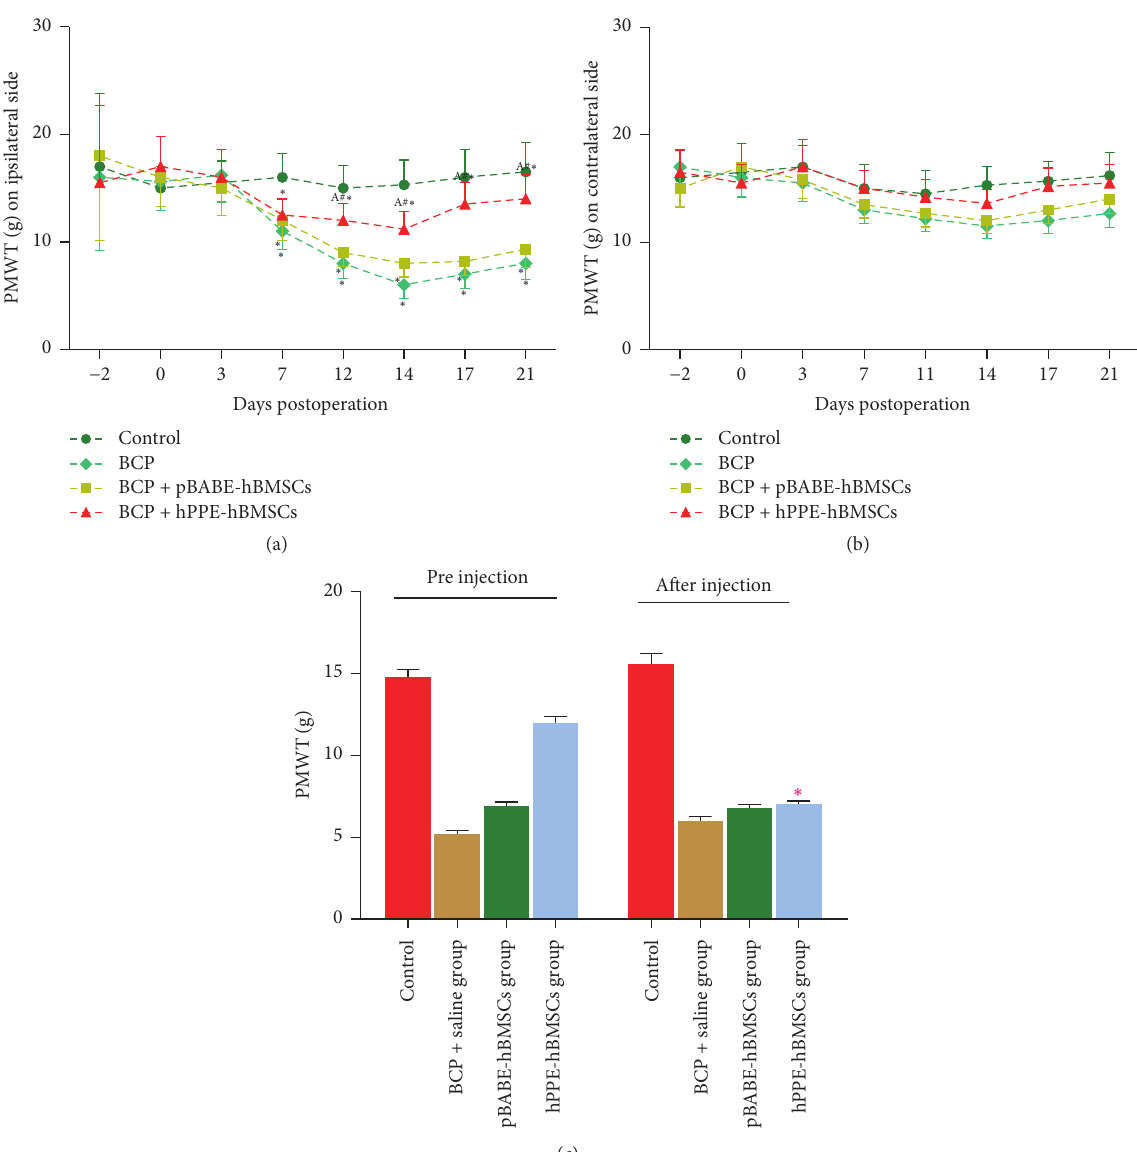
Figure 5: (a) Comparison of the paw mechanical withdrawal threshold (PMWT) indicating mechanical hyperalgesia changes on the ipsilateral side during the time course of Walker 256 cell incursion. Mechanical allodynia occurred starting on day 7, peaked on day 14, and then weakened until day 21. A significant decrease in PMWT was shown in the BCP, BCP + pBABE-hBMSCs, and BCP + hPPE-hBMSCs groups compared with the control group ( 𝑃 < 0.05 ), and treatment with hPPE-hBMSCs impaired the decrease in PMWT caused by cell administration. PMWT in the hPPE-hBMSC group was significantly higher than that in the BCP and pBABE-hBMSC groups ( 𝑃 < 0.05 ). ∗ 𝑃 < 0.05 versus the control group; # 𝑃 < 0.05 versus the BCP group; A 𝑃 < 0.05 versus the pBABE-hBMSC group. BCP, bone cancer pain; hPPE, human proenkephalin; pBABE, a retroviral vector; hBMSCs, human bone marrow stem cells; Control, the control group; BCP, the BCP + saline group; pBABE-hBMSCs, the pBABE-hBMSC group; hPPE-hBMSCs, the hPPE-hBMSCs group. 𝑛 = 6 . (b) Comparison of the paw mechanical withdrawal threshold (PMWT) indicating mechanical hyperalgesia changes on the ipsilateral side during the time course of Walker 256 cell incursion. There were no significant differences among the groups ( 𝑃 > 0.05 ). BCP, bone cancer pain; hPPE, human proenkephalin; pBABE, a retroviral vector; hBMSCs, human bone marrow stem cells; Control, the control group; BCP, the BCP + saline group; pBABE-hBMSCs, the pBABE-hBMSC group; hPPE-hBMSCs, the hPPE-hBMSC group, 𝑛 = 6 . (c) Naloxone was used to reverse the antiallodynia effect of met-enkephalin in bone cancer rats. The results showed that paw mechanical withdrawal threshold (PMWT) was significantly reduced after naloxone administration ( 𝑃 < 0.05 ). ∗ 𝑃 < 0.05 versus PMWT of the hPPE-hBMSCs group before injection. BCP, bone cancer pain; hPPE, human proenkephalin; pBABE, a retroviral vector; hBMSCs, human bone marrow stem cells. 𝑛 = 6